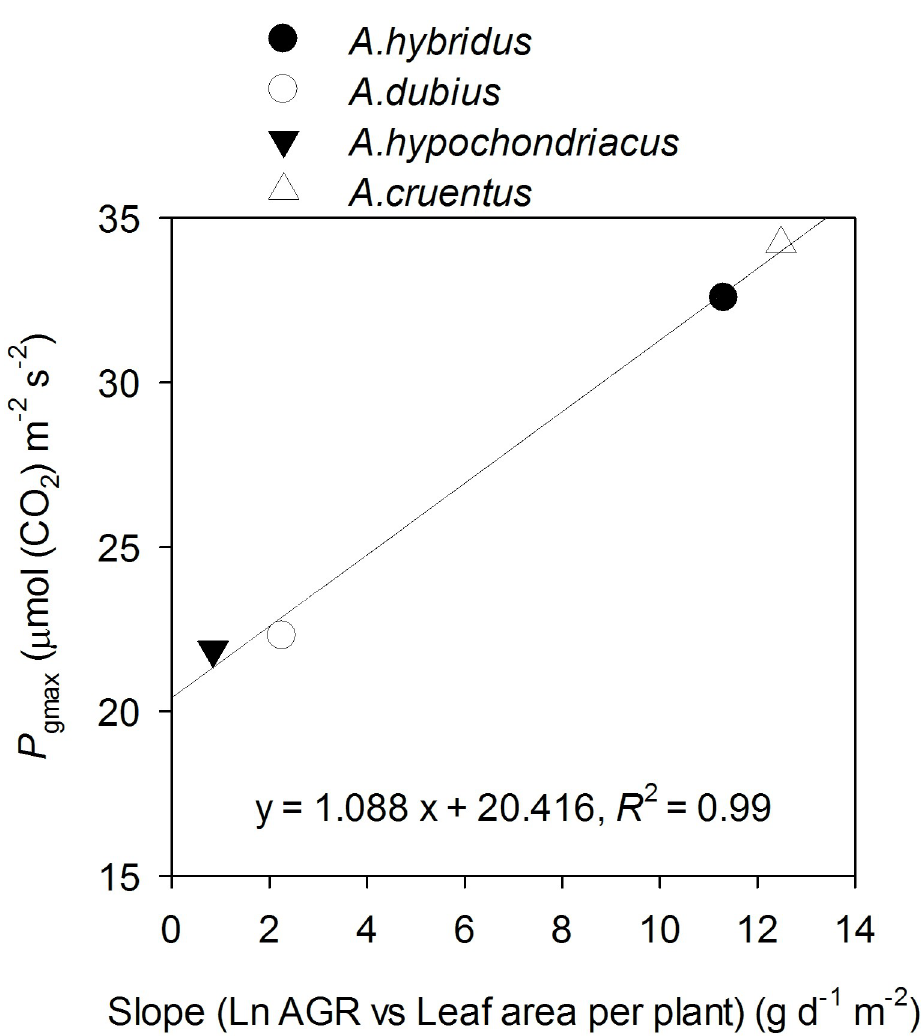
Fig 6. The relationship between maximum gross photosynthetic rate ( P gmax ) and the slope between the natural logarithm of absolute growth rate and leaf area per